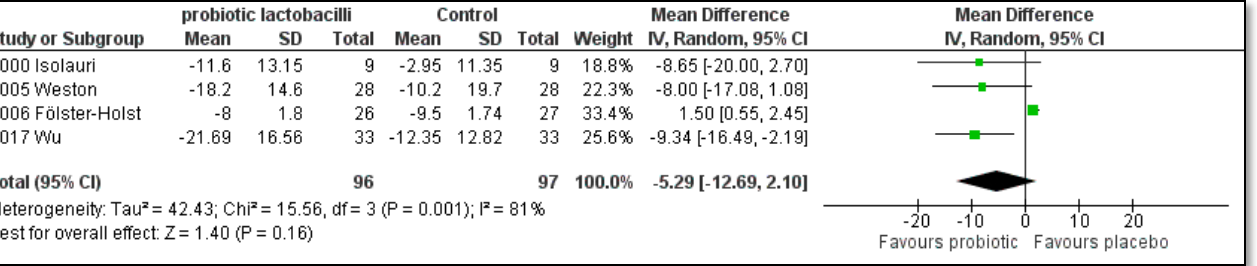
Figure 4. Subgroup meta-analyses of the effect of 8 weeks treatment time with single-strain probiotic lactobacilli compared to placebo on the SCORAD index change in children with AD